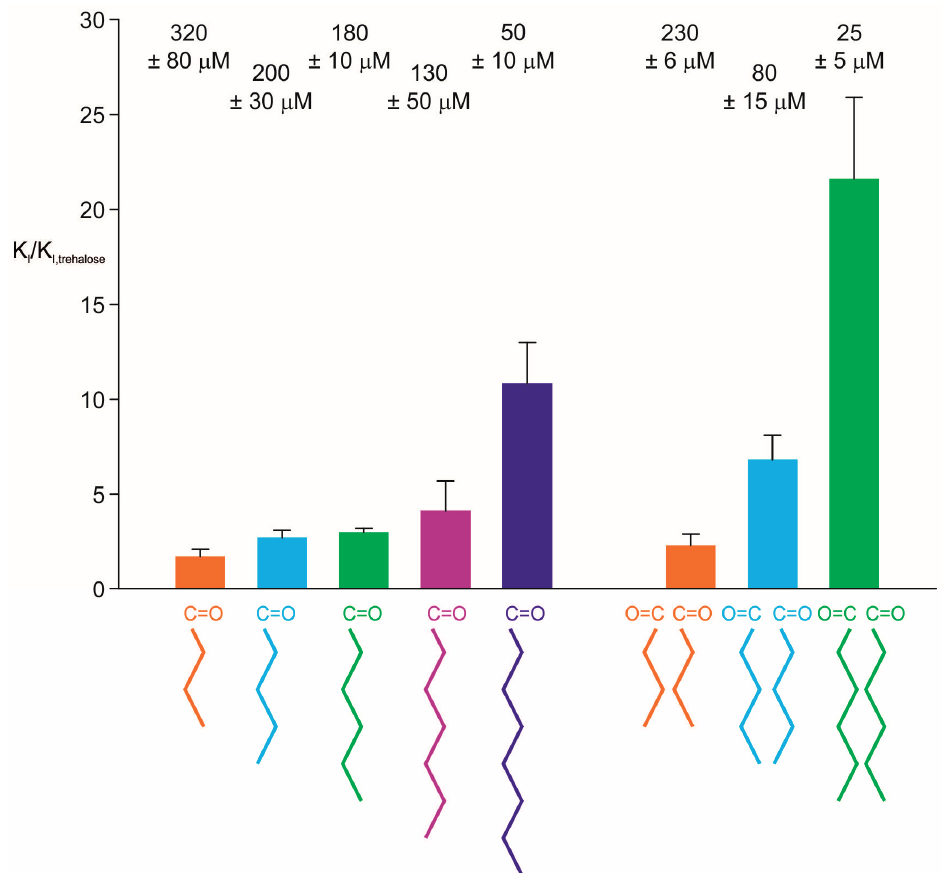
Figure 4. Summary of results for mouse mincle binding to mono- and di-acyl derivatives of trehalose. Affinities for trehalose derivatives were determined using the competition binding assay. The results are expressed as means ± standard deviations, both numerically as K I values at the top and graphically as relative affinities compared to trehalose at the bottom.